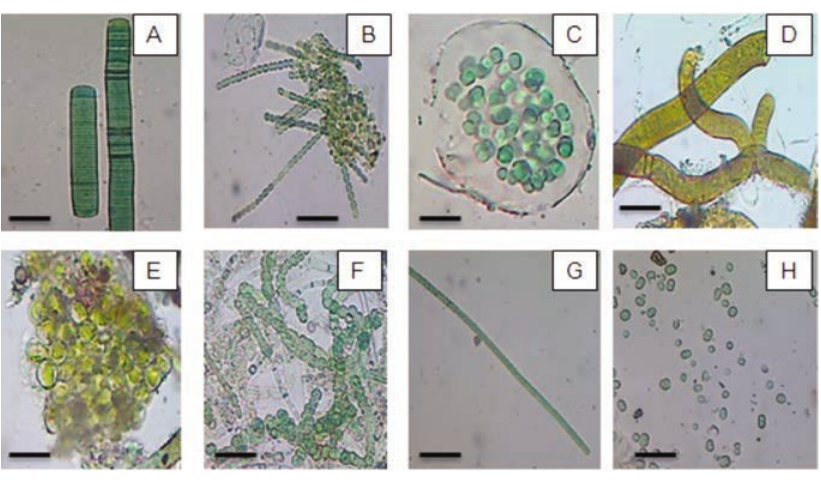
Figure 3. Cyanobacteria isolated from different historical monuments of Varanasi (A) Lyngbya sp., (B) Anabaena sp., (C) Nosto c sp., (D) Scytonema sp., (E) Aphanocapsa sp., (F) Westiellopsis sp., (G) Phormidium sp. and (H) Aphanothece sp. Scale bar = 10